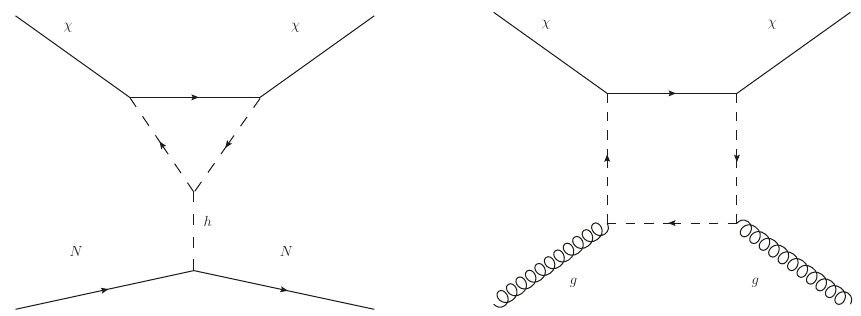
Figure 4 . Exemplary one-loop diagrams contributing to the e(cid:11)ective DM nucleon coupling. The triangle diagram (left) contributes to the direct detection rate through an e(cid:11)ective coupling to the Higgs while the box (right) leads to an interaction with the gluons content of the nucleons. =M 2 where x (cid:17) = M 2 and the quark masses have been neglected. This contribution is always (cid:17) (cid:31) subdominant but can amount to a O (10%) correction in certain regions of parameter space if (cid:21) 3 is